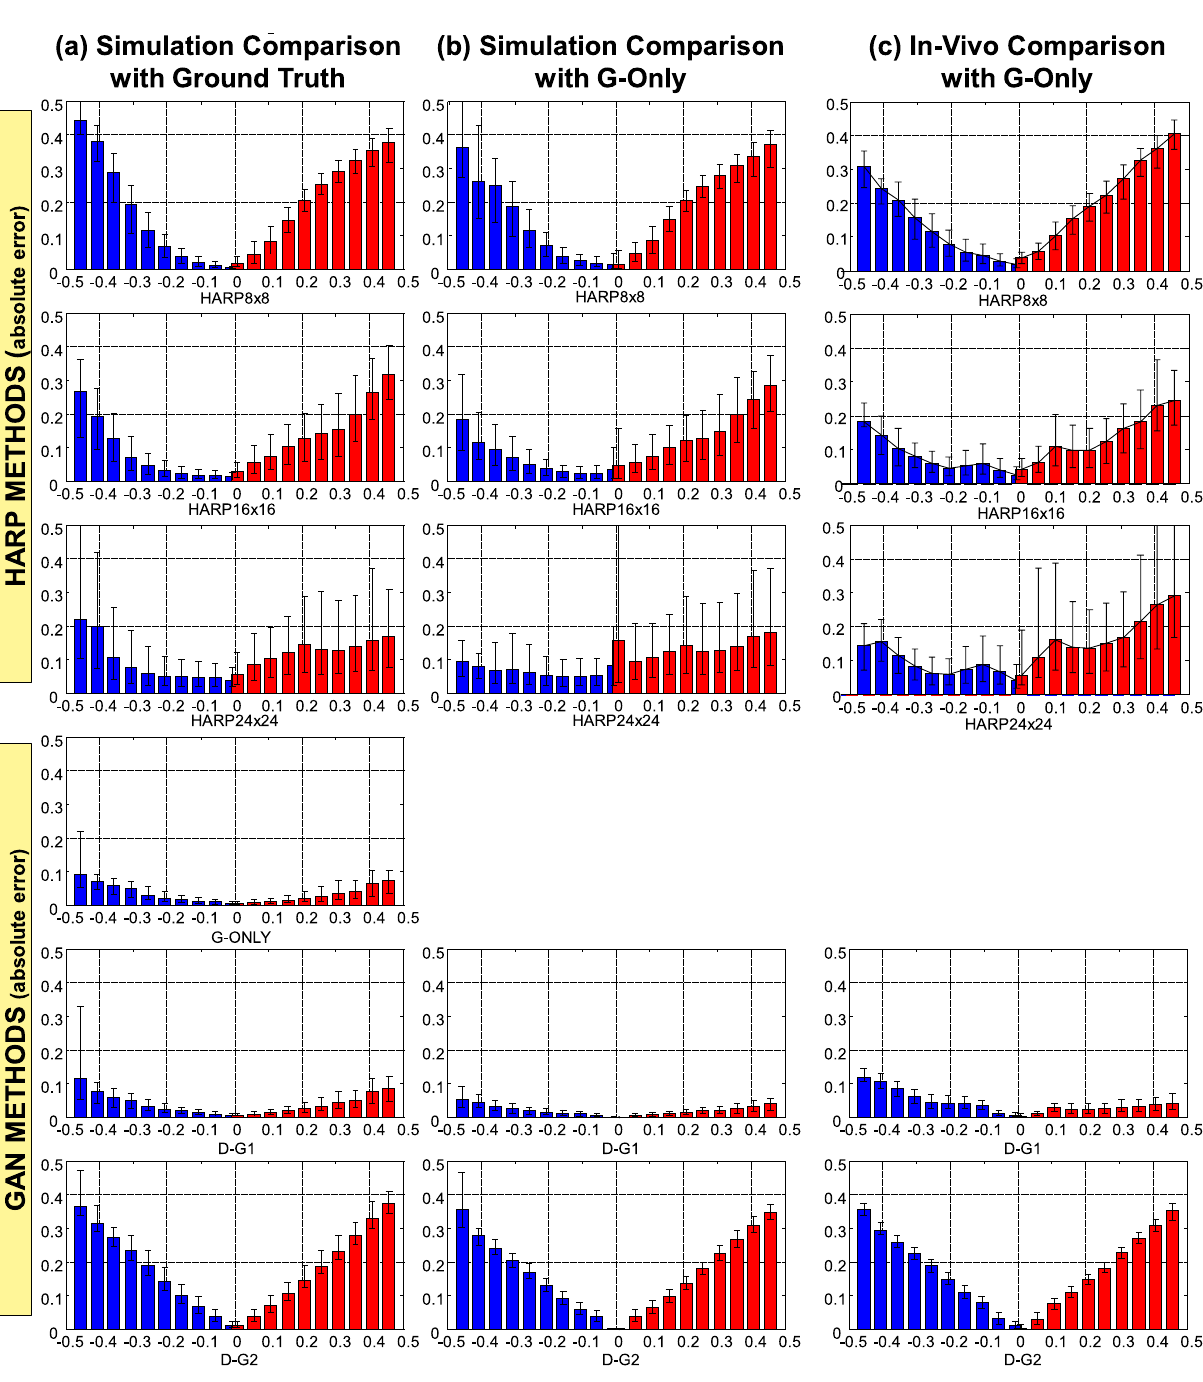
Figure 8. Histograms of the absolute errors in strain measurements for various HARP and proposed GAN methods compared to reference strain values. The absolute errors in the first and second principal strains ( ε p 1 and ε p 2 ) are represented by the red and blue bars, respectively. Datasets used for analysis and comparison